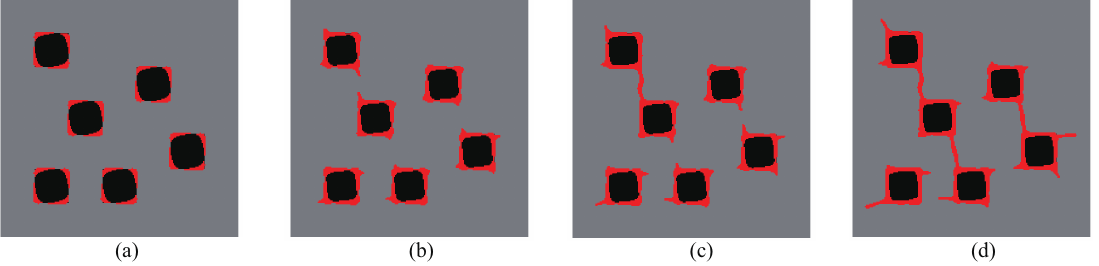
Figure 17. Crack propagation in the initial composite with randomly distributed inclusions subjected to loading case 3: ( a ) ¯ U = 5 mm; ( b ) ¯ U = 10 mm; ( c ) ¯ U = 11 mm; ( d ) ¯ U = 12 mm.